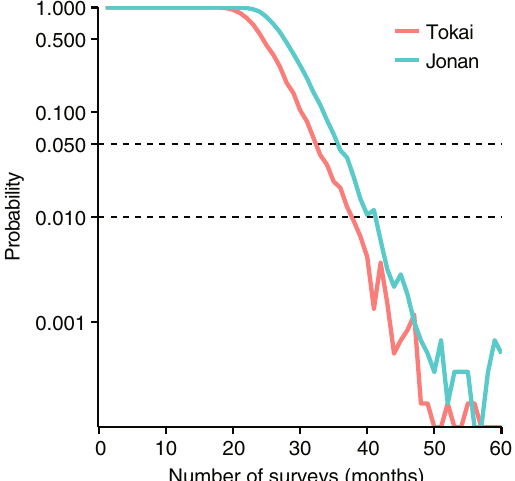
Figure 2. Posterior probabilities of the estimated occurrence of Argentine ants versus the number of surveys at the Tokai and Jonan sites. Dashed lines indicate posterior probabilities of 0.01 and 0.05.